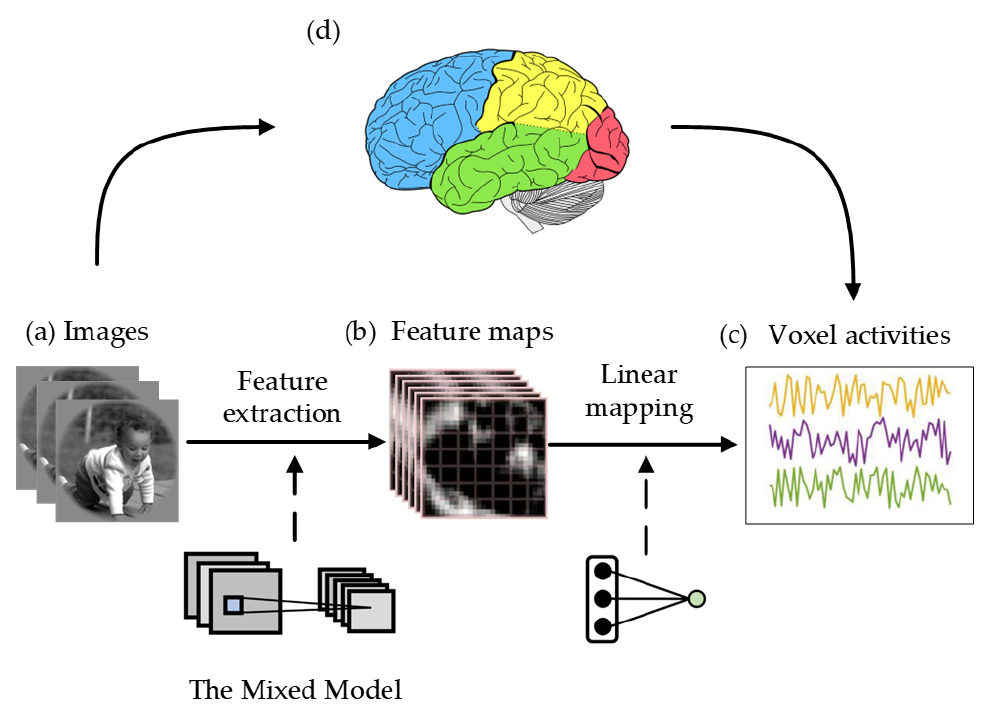
Figure 1. The mixed visual encoding model. ( a ) Images; ( b ) The feature maps from the pre-trained mixed model; ( c ) The voxel activities; ( d ) Information processing of the visual cortex in the brain. When the brain’s visual cortex processes external images, fMRI can measure activity responses. Meanwhile, the linearized visual encoding methods extract image features from pre-trained mixed models. The visual encoding model uses the fMRI and image feature data in the training set as input to train the linear regression model. Then, the linear model obtains the inferred fMRI voxel by inputting the image feature map from the test set. Finally, the visual encoding model calculates the